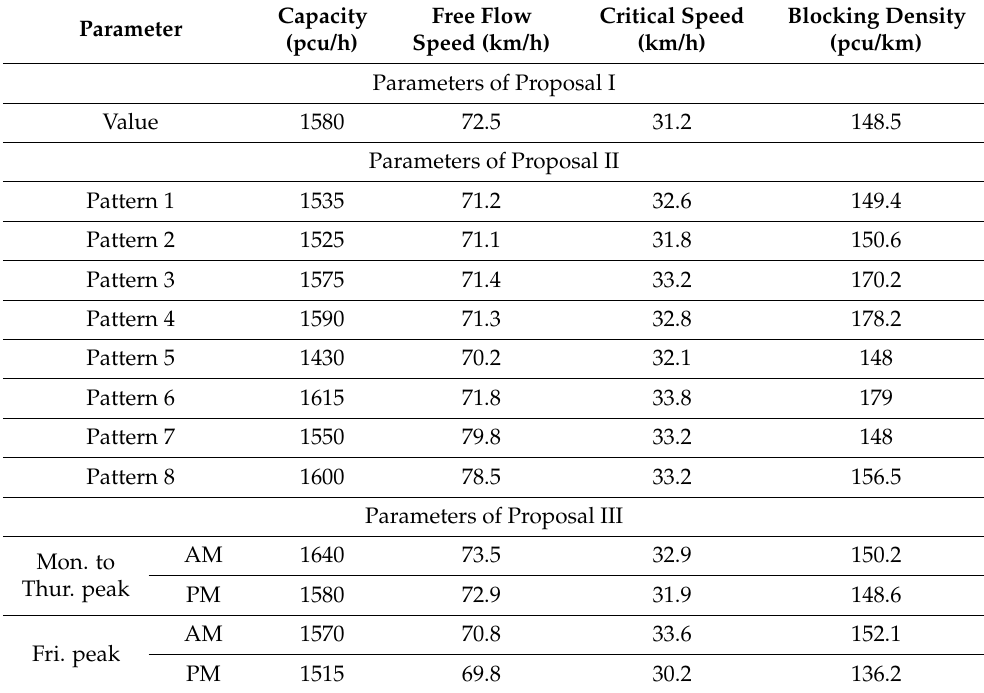
Table 5. Traffic flow characteristic parameters of different proposals on